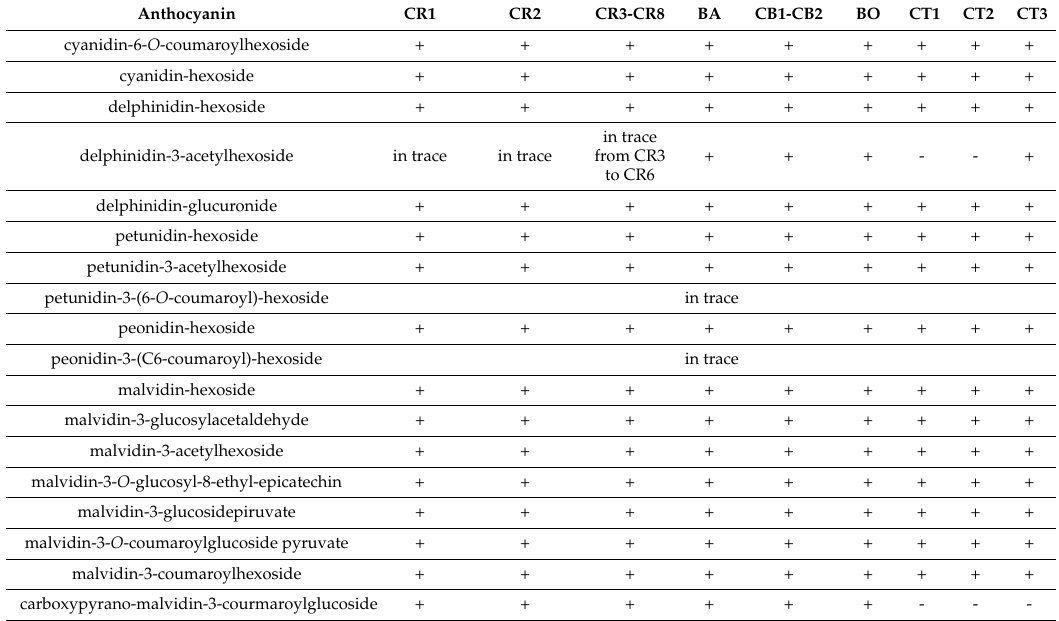
Table 4. Presence (+) or absence (-) of the identified anthocyanins in the 15 wine